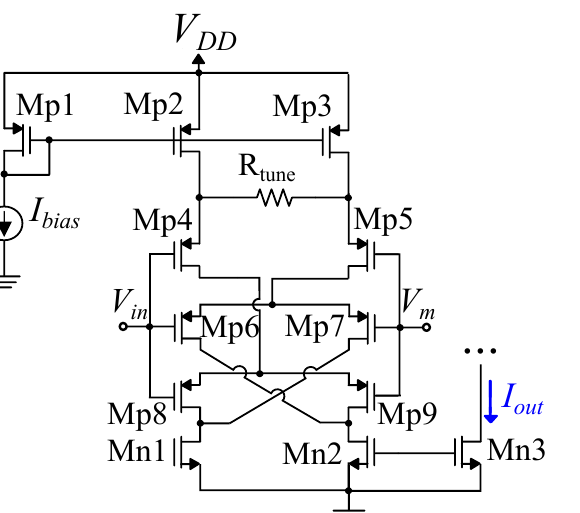
Figure 30. A modified Gilbert’s Gaussian circuit, using a series of resistors controlled via switches.